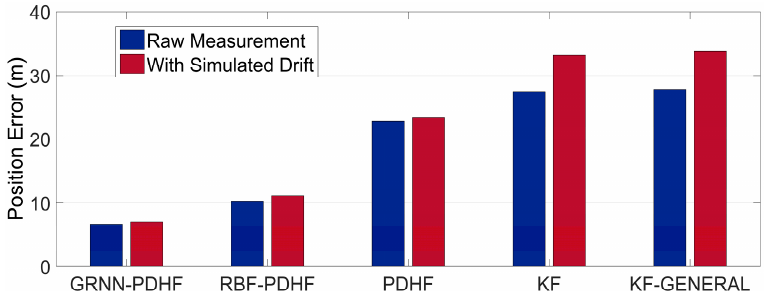
Figure 12. Maximum position error during outage 5 in trajectory 1 while using raw measurement and with extra simulated uncertain nonlinear drift.